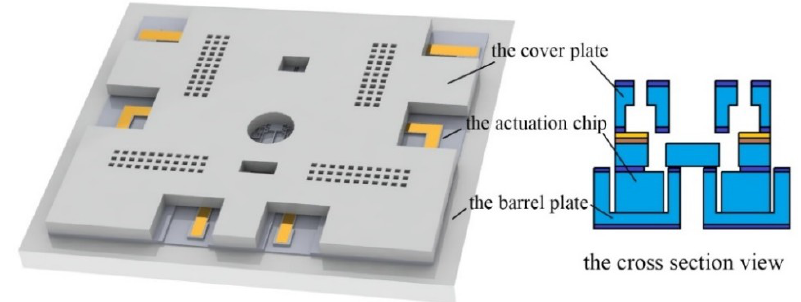
Figure 1. The structure of MEMS safety‑and‑arming (S&A) device.